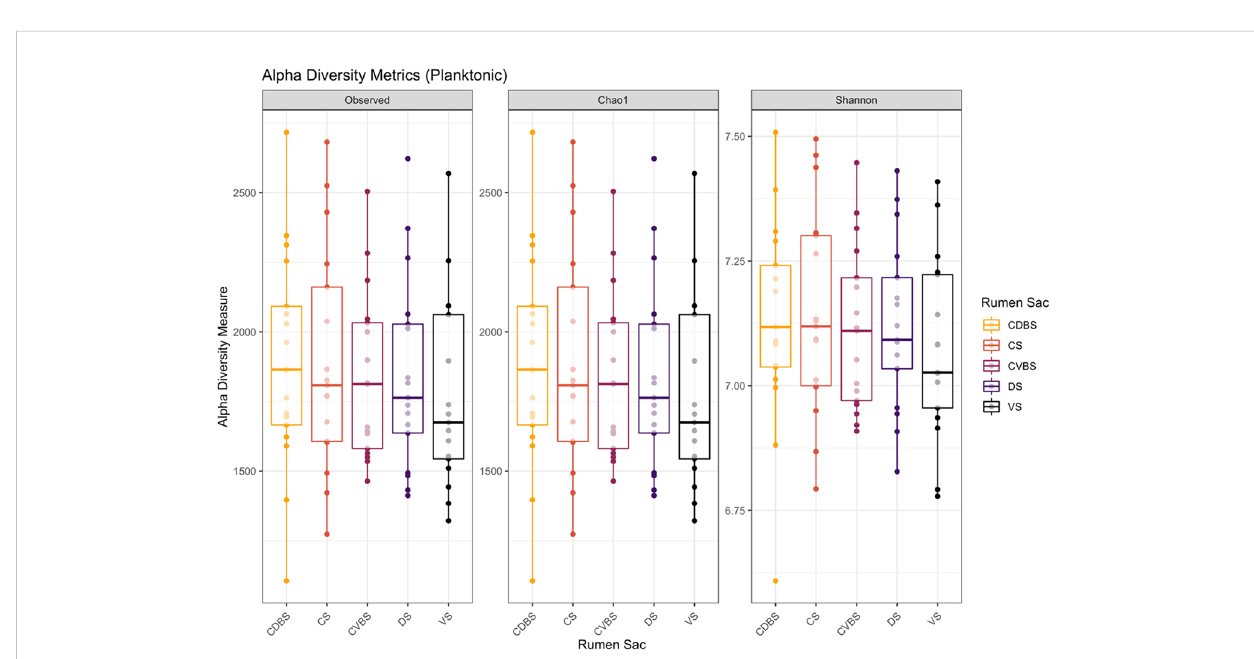
FIGURE 7 Alpha diversity metrics in the planktonic fraction among the fi ve rumen sacs. Alpha-diversity metrics for the planktonic bacterial communities among each of the fi ve rumen sacs. Measures were observed ASVs (richness), Chao1 (expected richness), and Shannon diversity index (richness and evenness). The CDBS is in orange, CS is in red, CVBS is in light purple, DS in dark purple, and VS is in black. With the removal of singletons during data analysis, the Chao1 measurement may appear similar to the observed measurement. No signi fi cance was identi fi ed within the planktonic microbial community among the rumen sacs (P > 0.05).